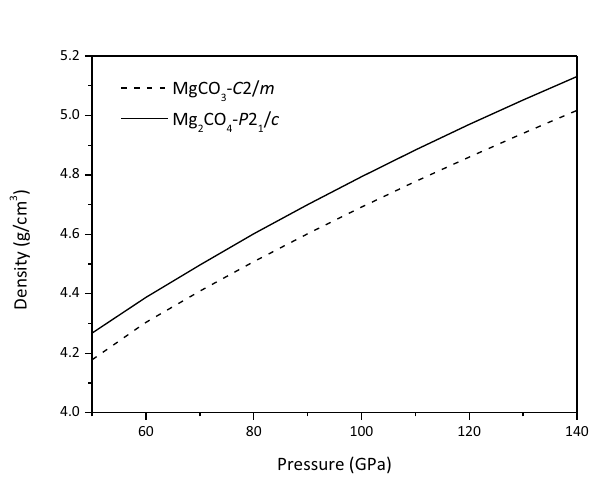
Figure 7. Density of MgCO 3 - C 2 /m and Mg 2 CO 4 - P 2 1 /c